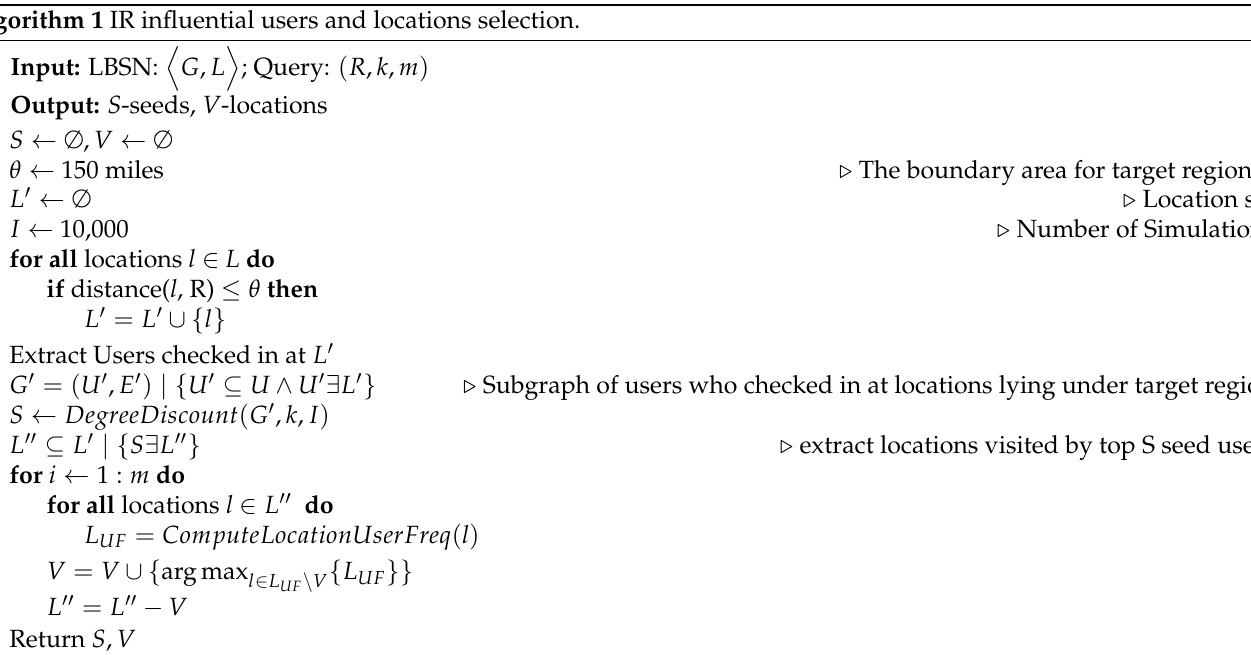
Algorithm 1 IR influential users and locations